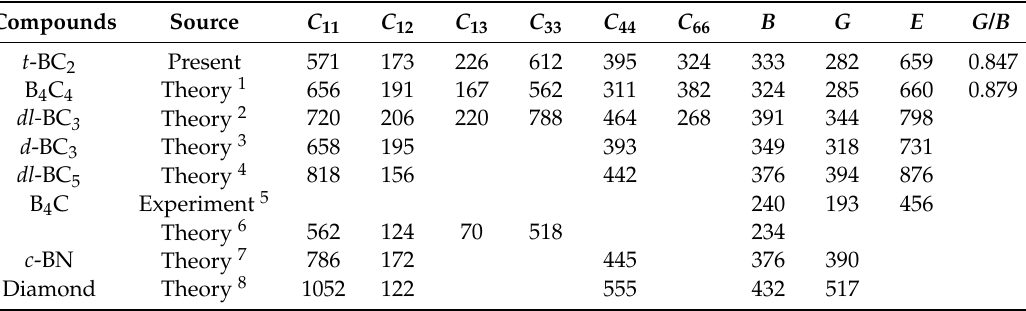
Figure 1. The crystal structure and the dependence of normalized lattice constants and cell volume on pressure for t- BC 2 . The blue and black spheres denote B and C atoms, respectively. Table 1. Calculated elastic constants C ij , bulk modulus B , shear modulus G , and Young’s modulus E (in units of GPa). Also shown is G / B ratio.